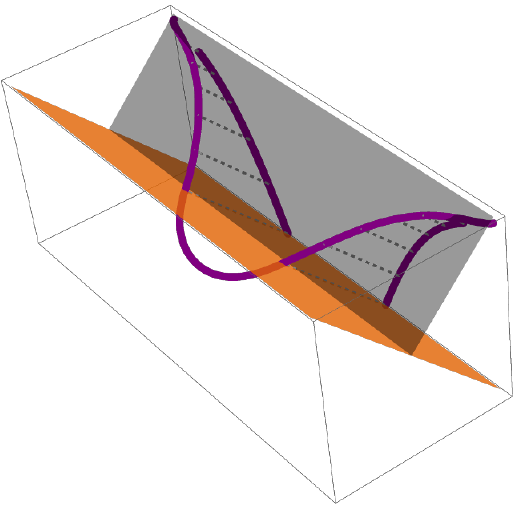
Figure 2 . Projection of the HRT surface into the membrane picture. Only the region between the infalling matter (Orange) and the horizon (Gray) contribute to leading order in the scaling